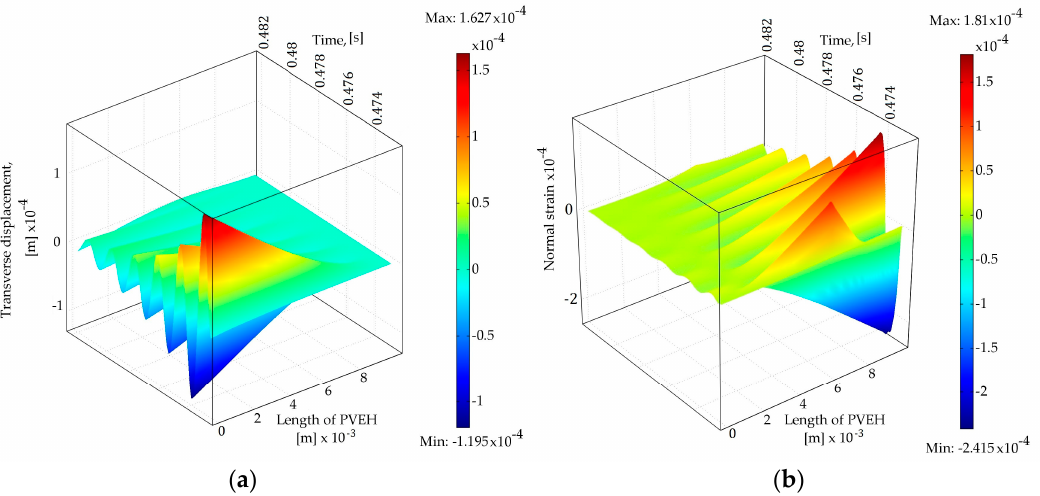
Figure 2. Dynamic process of the PVEH from the instant of impact to fully decayed vibration (LFR—103 Hz, contact point position at 0.6 L) ( a ) transverse displacement and ( b ) normal strain distribution through the length of the PVEH.